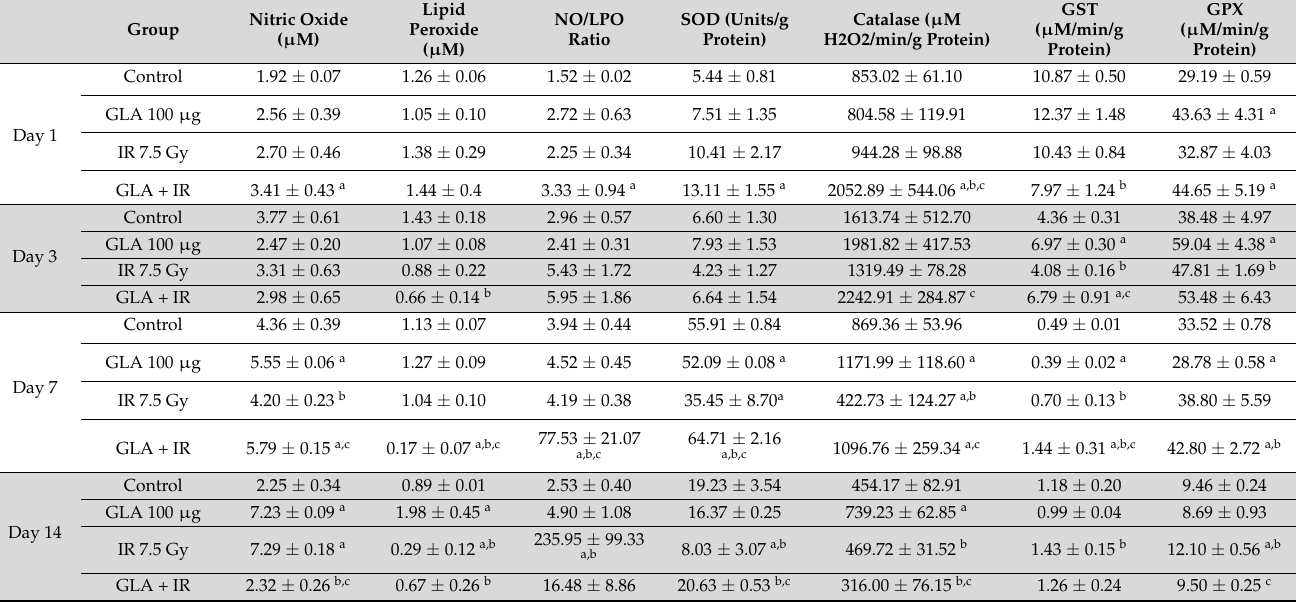
Table 3. Mouse duodenal tissue NO, lipid peroxides, and antioxidants following various